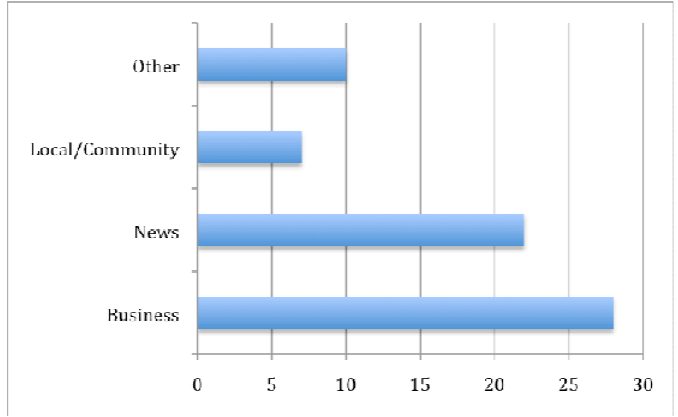
Figure 3: Newspaper sections in which articles